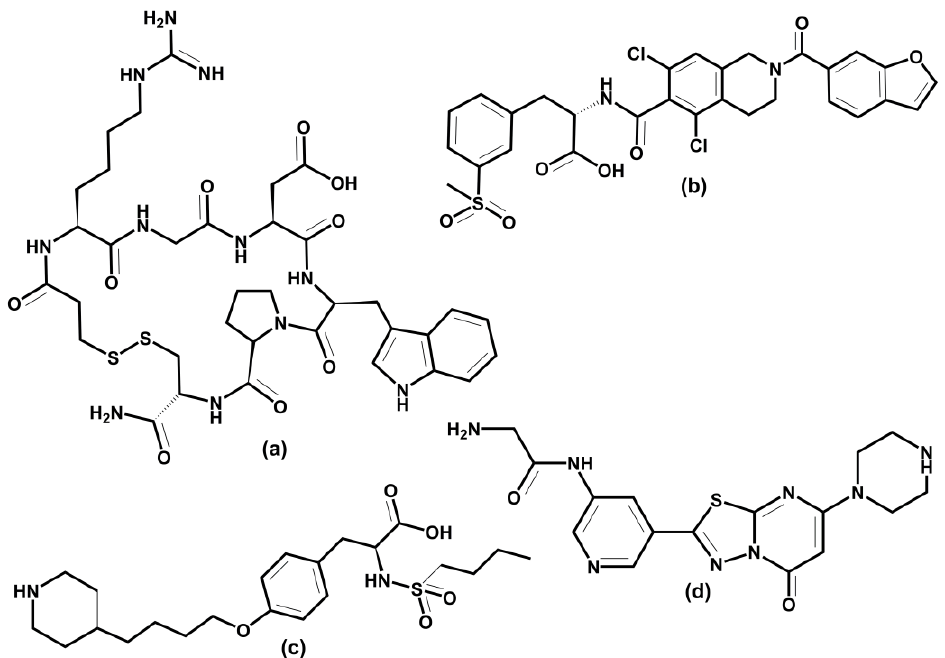
Figure 11. Schematic representation of the three small molecule marketed drugs: ( a ) eptifibatide, ( b ) tirofiban, ( c ) lifitegrast, and ( d ) zalunfiban (RUC-4), compound in the Phase 3 clinical trial.